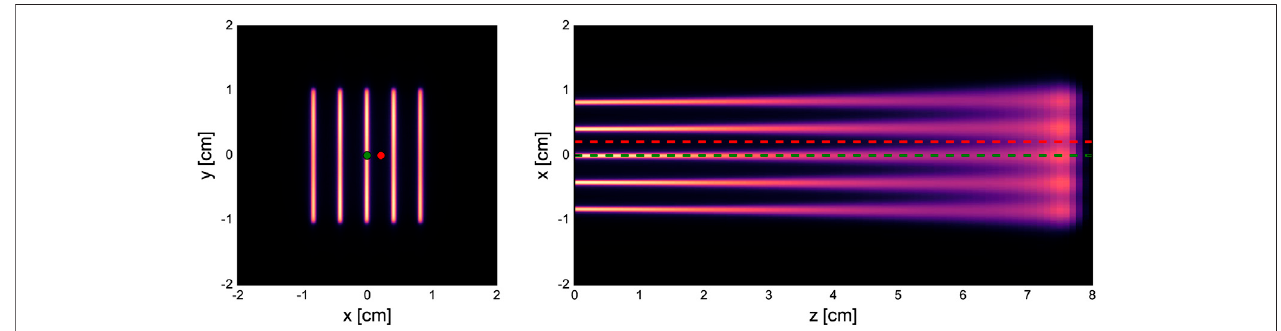
FIGURE 1 | Dose distribution in the water phantom for 100-MeV minibeams obtained with collimator and PBS (C+PBS). Left: lateral cross section at the phantom entrance. Right: longitudinal cross section at y (cid:2) 0 cm. The green and red dots/dashed lines indicate considered peak and valley regions, respectively.